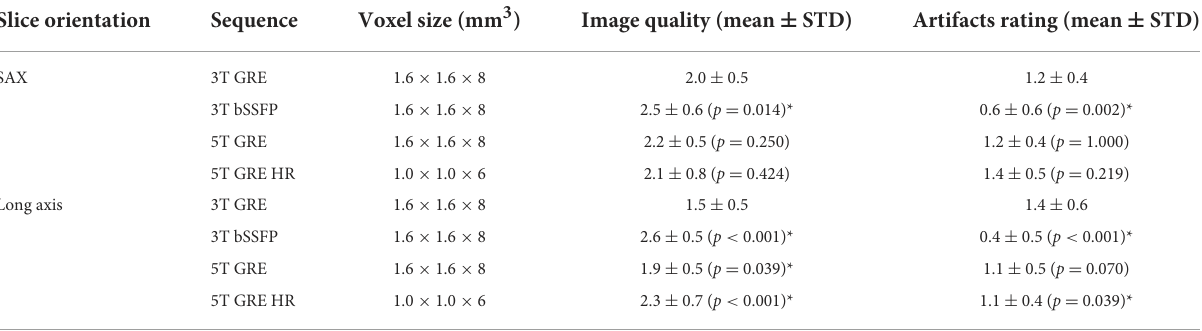
TABLE 2 Rating of overall image quality and presence of artifacts, using 3T GRE as reference. Slice orientation